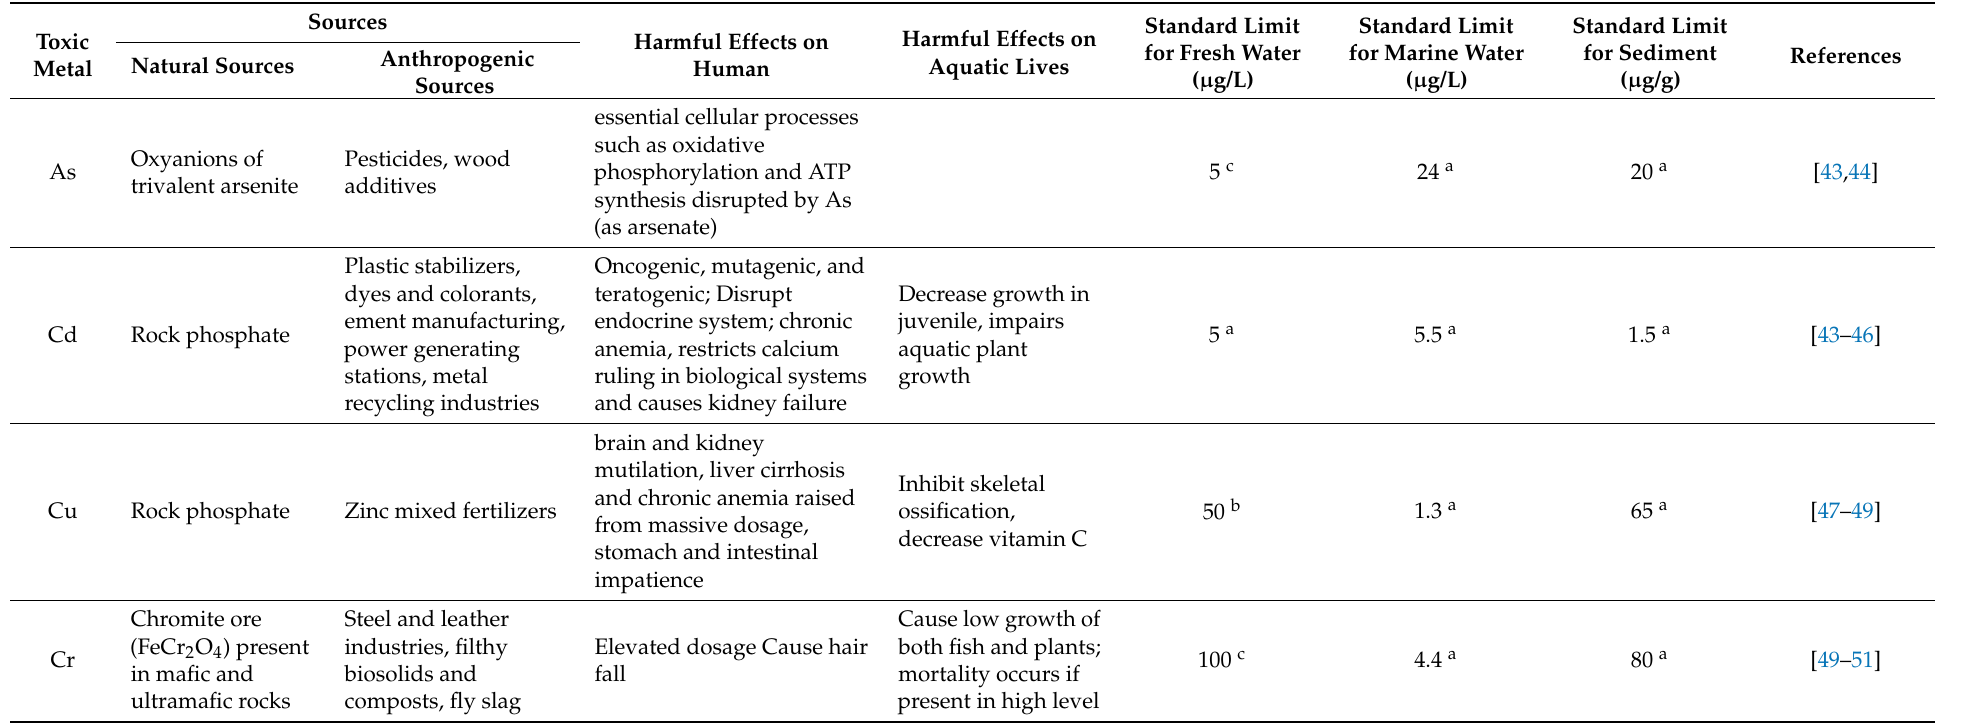
Table 1. Source, effect and limit of different harmful